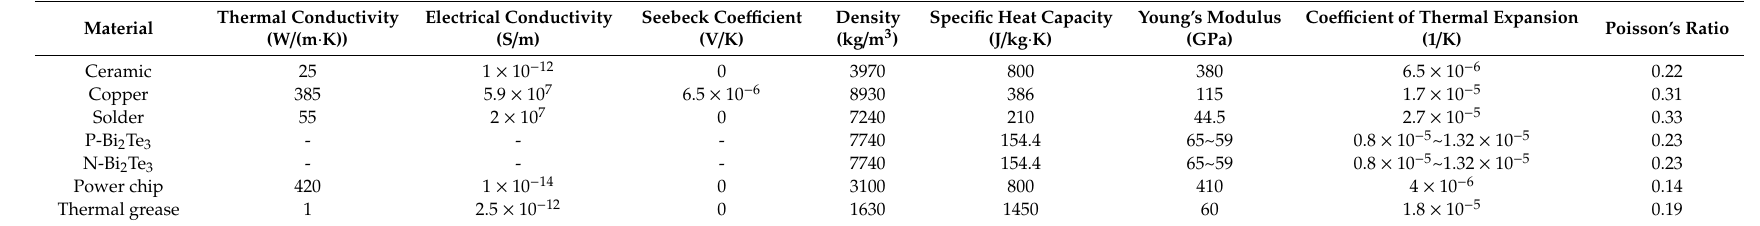
Table 2. Other material properties used in this simulation